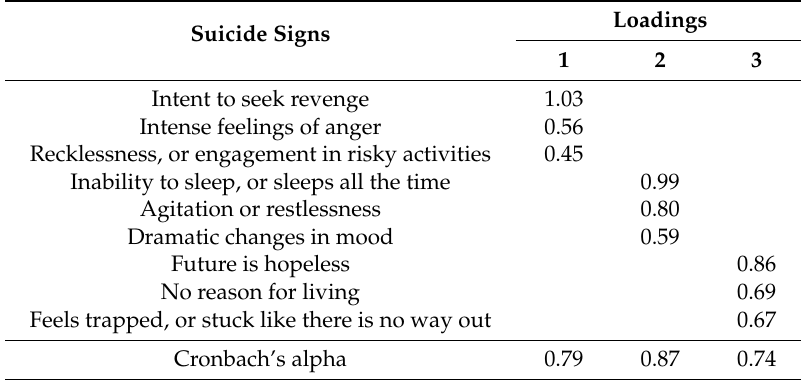
Table 2. Direct oblimin rotated factor structure of patterns of suicide signs associated with suicide risk in male crisis line callers.